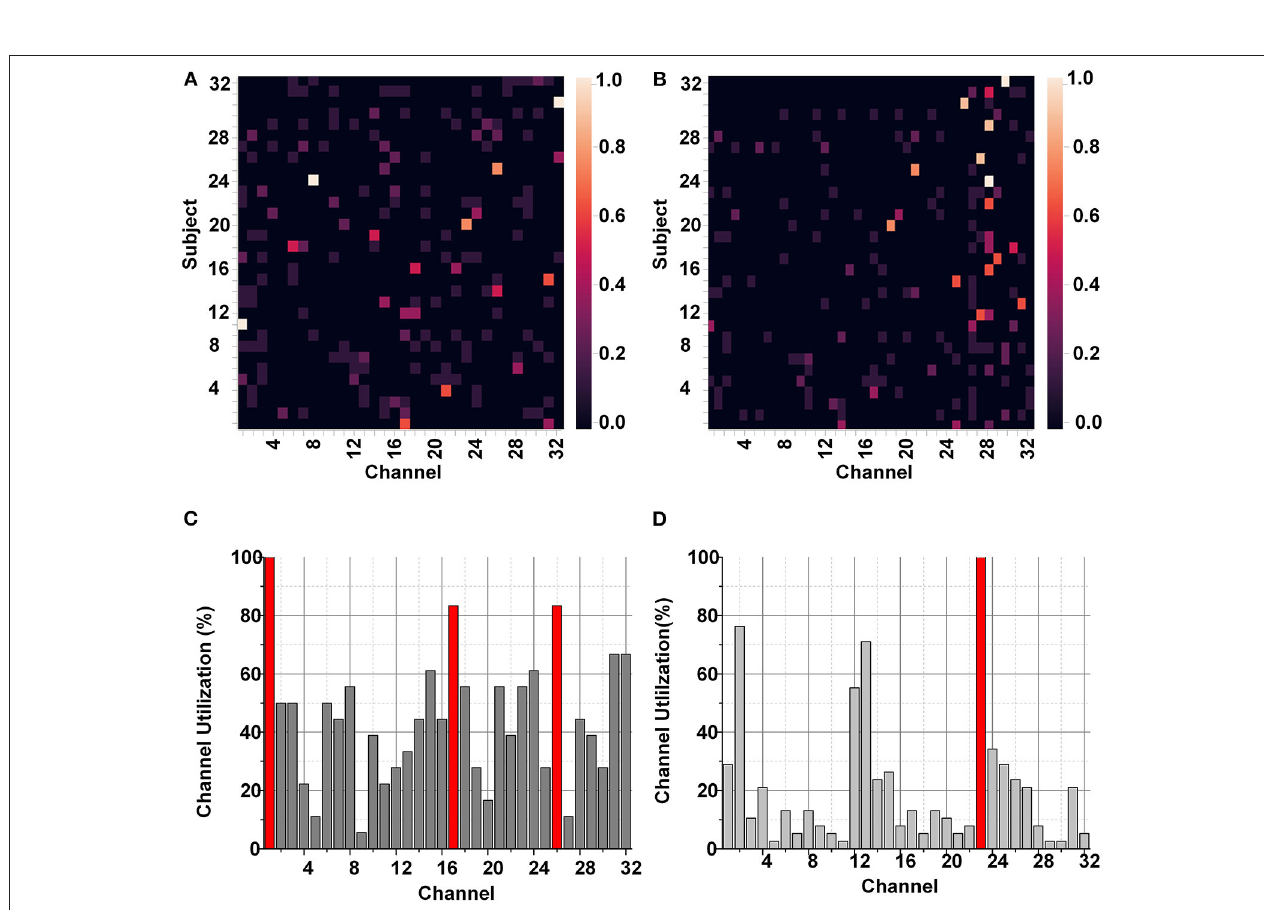
FIGURE 6 | (A) Heat map for channel selection using SKB, (B) Heat map for channel selection using SFS, (C) Bar graph for channel selection using SKB, and (D) Bar graph for channel selection using SFS for DEAP data set.